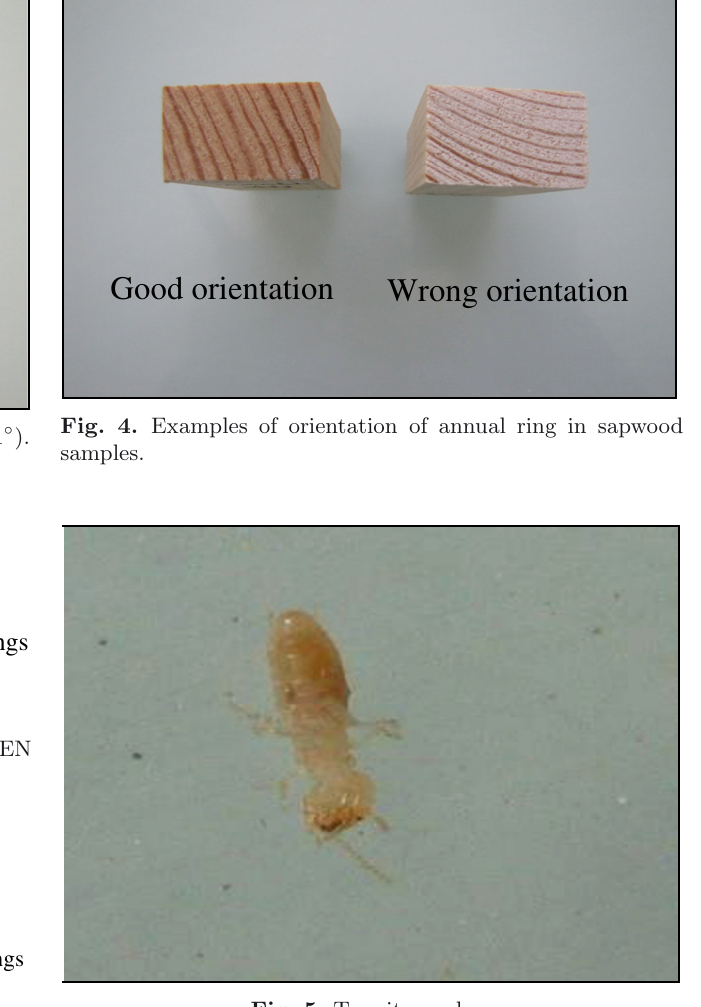
Fig. 5. Termite worker.